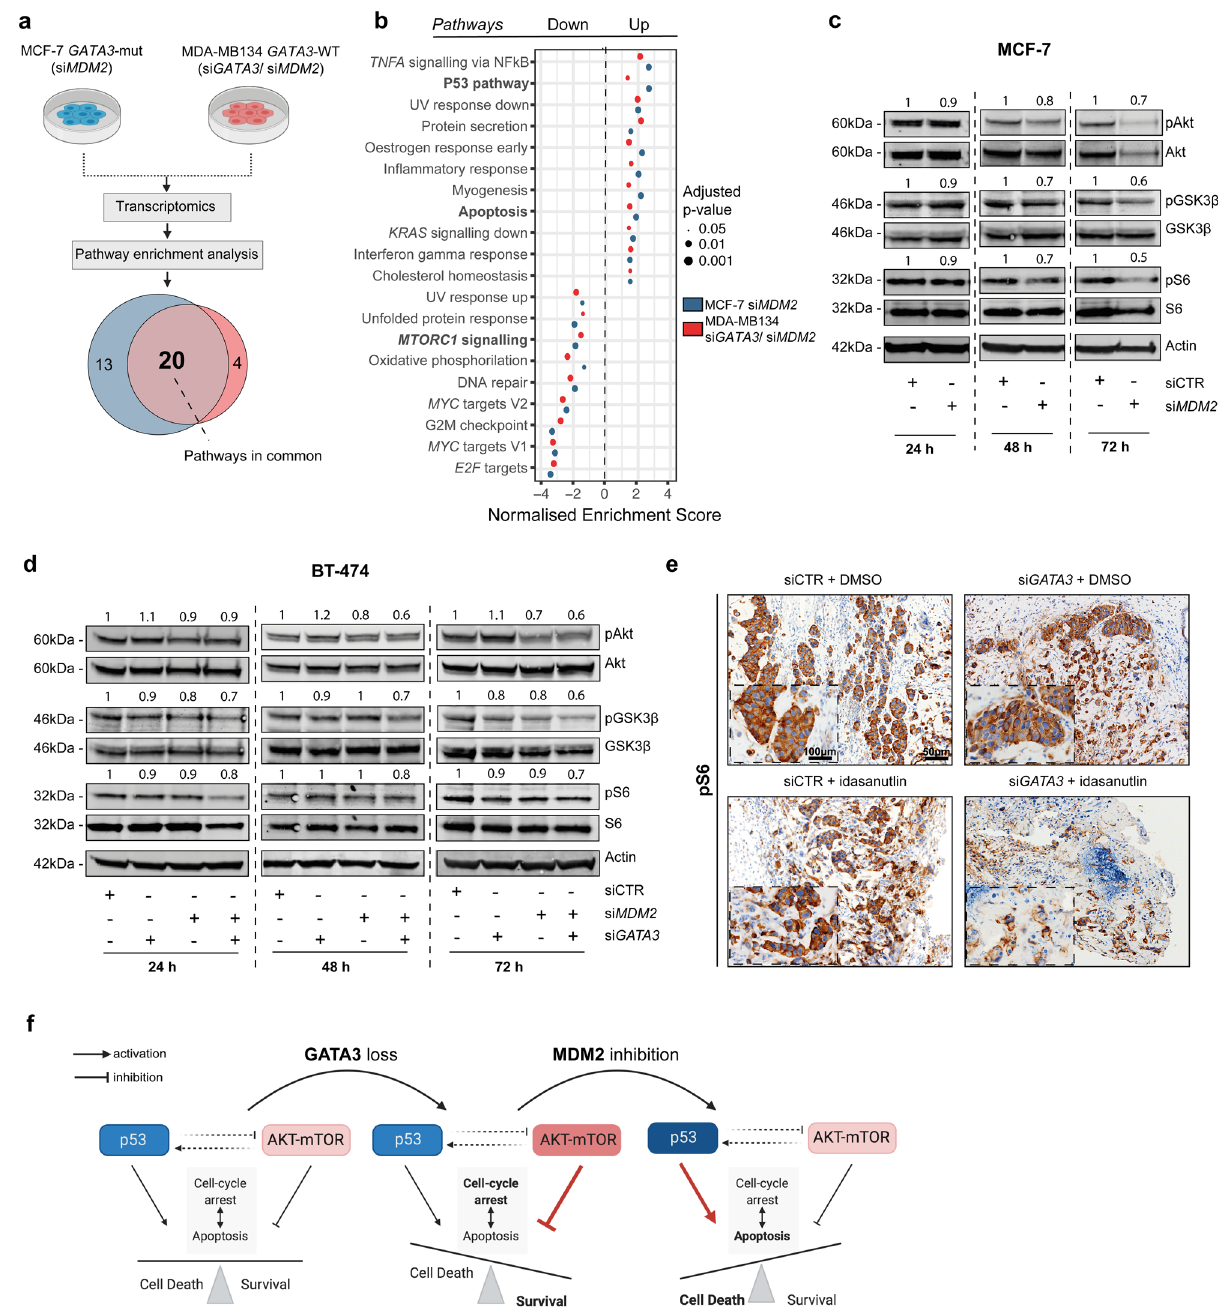
Fig. 6 The synthetic lethality between GATA3 and MDM2 acts via the PI3K-Akt-mTOR signaling pathway. a Schematic representation of the RNA-seq experimental setup to identify gene expression changes induced by concurrent GATA3 loss and MDM2 inhibition. Venn diagram shows the number of pathways enriched in both MCF-7 with MDM2 siRNA and MDA-MB134 with GATA3 siRNA and MDM2 siRNA. b Normalized enrichment scores of signi fi cantly up- and down-regulated pathways identi fi ed by gene set enrichment analysis in both MCF-7 and MDA-MB134. The size of the dots is proportional to the adjusted p-value as indicated in the legend. c , d Immunoblot showing markers of mTOR signaling pathway activation at 24, 48, and 72 h post-siRNA transfection in c MCF-7 cells upon MDM2 silencing and d BT-474 cells upon GATA3 and/or MDM2 silencing (see also Supplementary Fig. 6a, c, d). For all the western blots, quanti fi cation is relative to the loading control (actin) and normalized to the corresponding siCTR. e Representative immunohistochemistry micrographs of phospho-S6 stainings in BT-474 tumors extracted four days post-implantation in the CAM model (see also Supplementary Fig. 6e). f Schematic representation of the mechanistic hypothesis. Scale bars: e 50 and 100 μ m. Statistical signi fi cance was determined for b by fgsea . a , f were created with